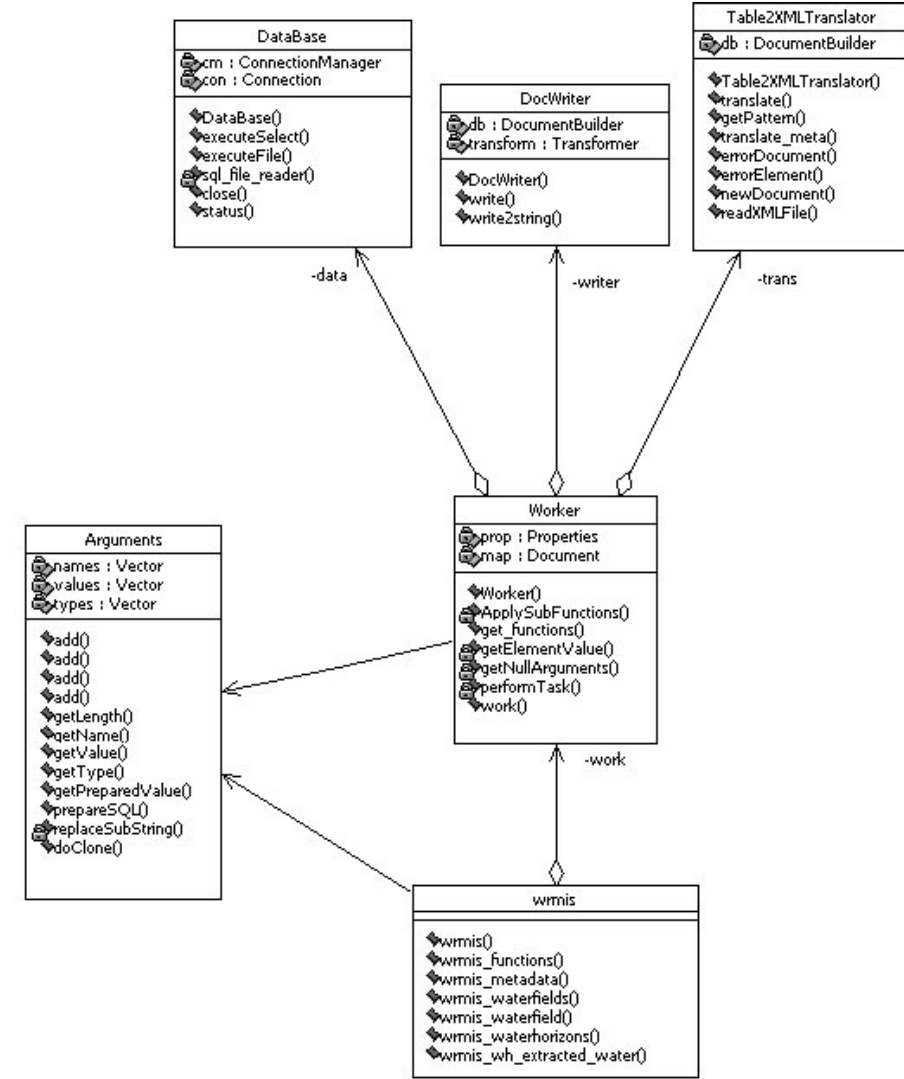
Fig. 5. Class diagram of lgt.* package in Ground Water Web